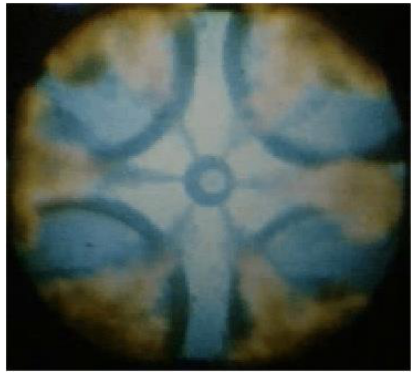
Fig. 2. Combustion photo by the lower window observation